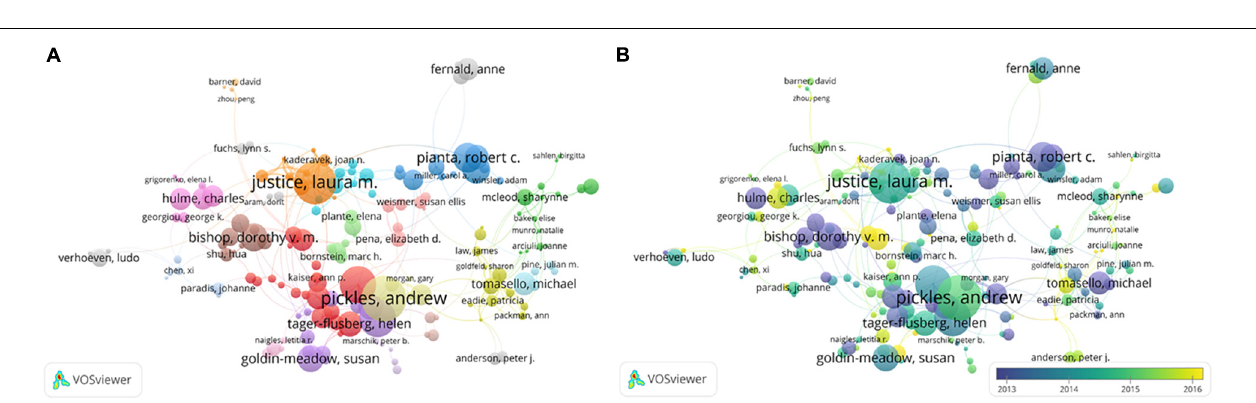
FIGURE 5 | Authors’ cooperation network in the CL research field. (A) The co-authorship network for all items. (B) The co-authorship network for the largest set of items.